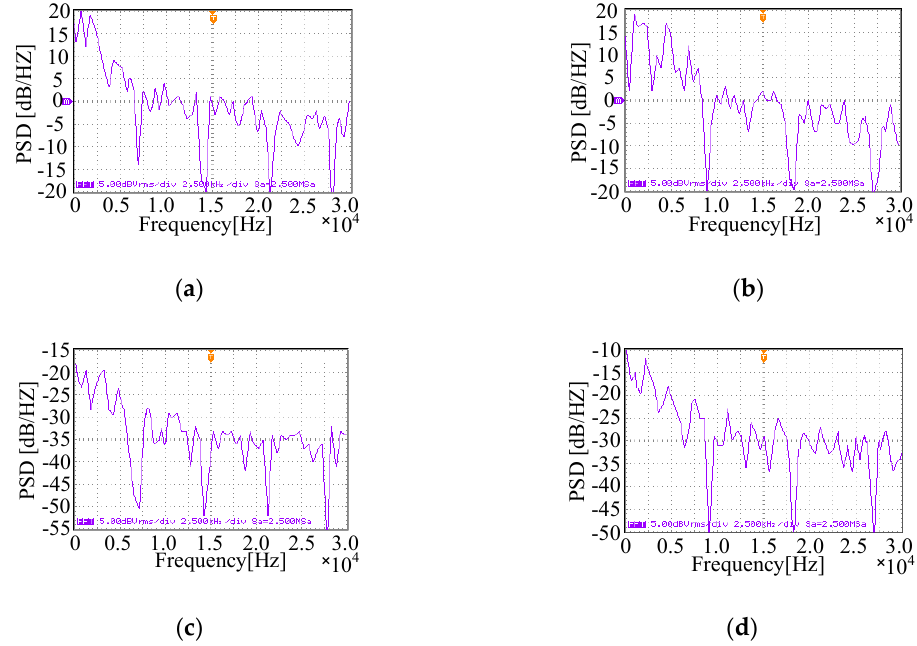
Figure 9. Experimental waveforms of PSD when M is 0.9. ( a ) The PSD of voltage when f 0 is 7 kHz; ( b ) the PSD of voltage when f 0 is 9 kHz; ( c ) the PSD of current when f 0 is 7 kHz; ( d ) the PSD of current when f 0 is 9 kHz.